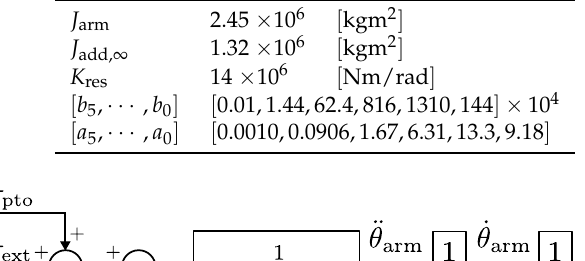
Table 1. Float model parameters.